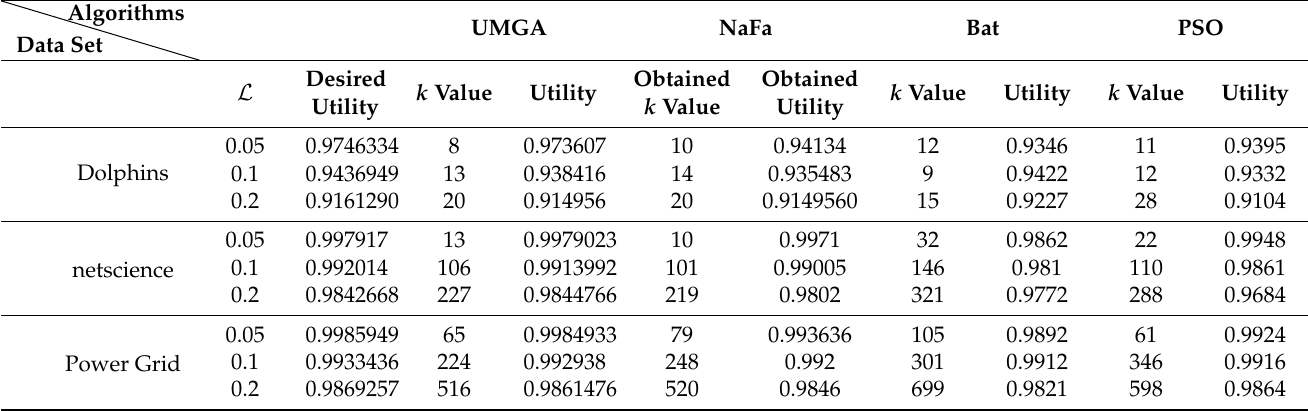
Table 6. The evaluation results of optimization algorithms with respect to the obtained k value and